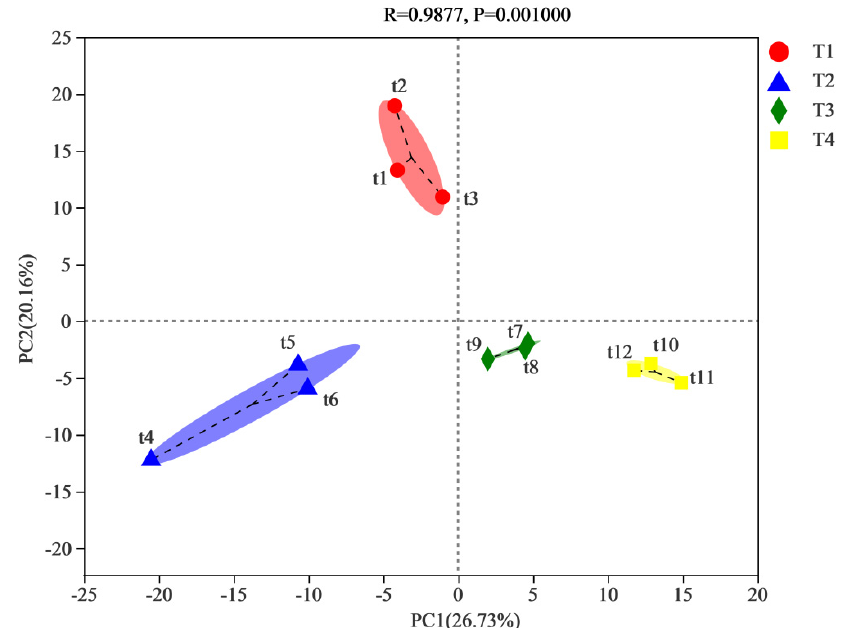
Figure 2. Principal component analysis (PCA).